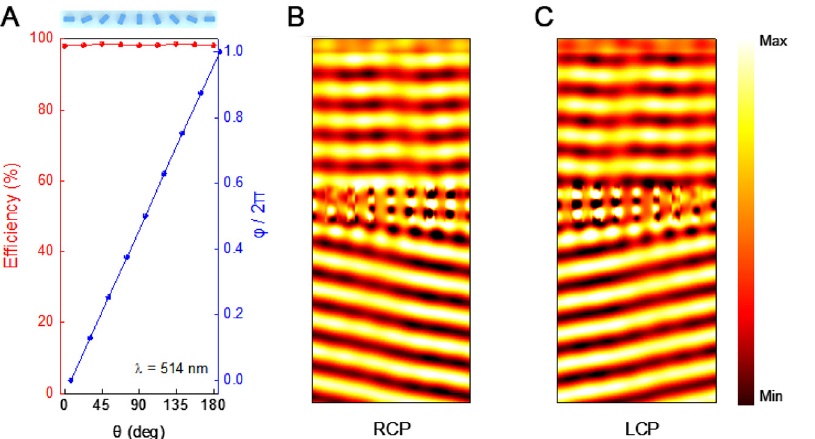
Figure 3: Angular dependence of phase and polarization conversion efficiency of nanofin and electric field maps. (A) Simulated polarization conversion ef fi ciency (red points) and phase (blue points)ofanano fi nwith θ varyingfrom0 ° to 180 ° . (B and C) Simulated electric fi eld maps for RCP and LCP illumination,